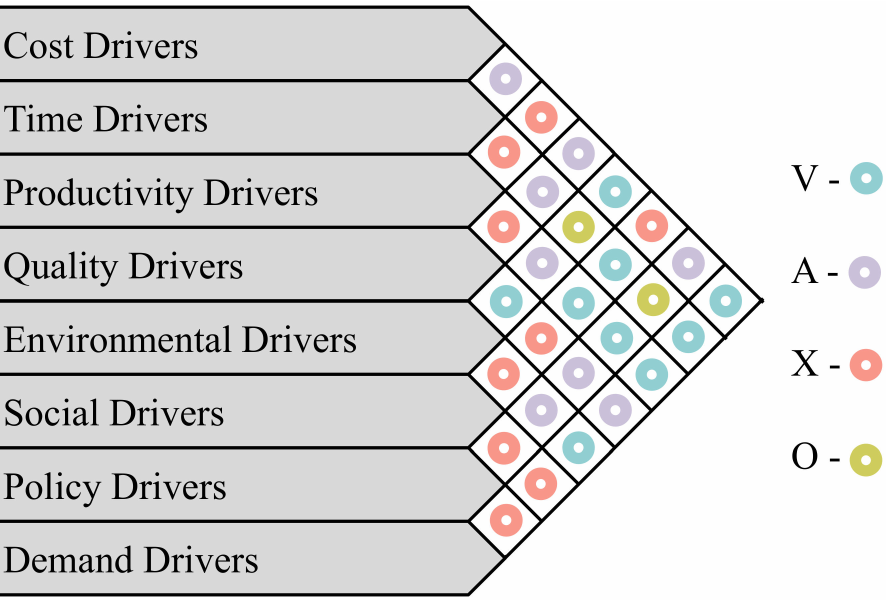
Figure 7. SSIM depiction in matrix